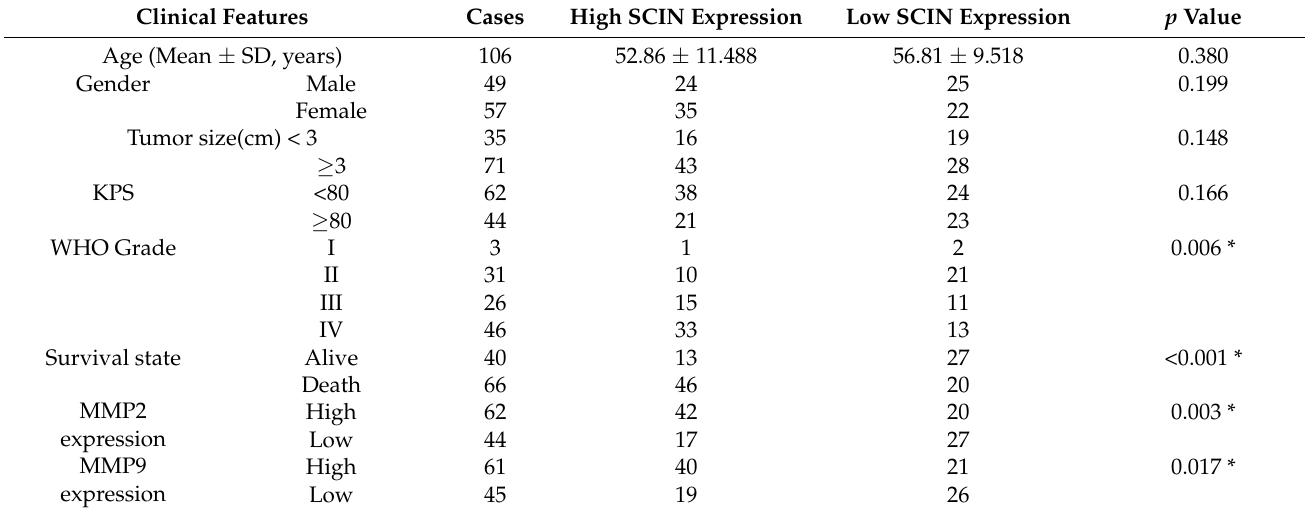
Table 1. Clinical features and SCIN expression in 106 glioma